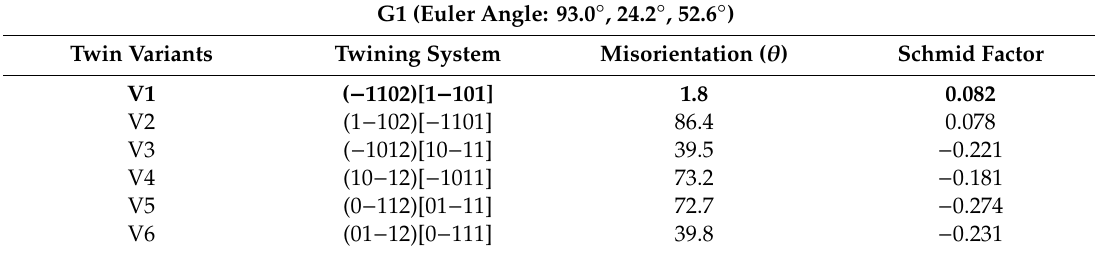
Table 3. Misorientation ( θ ) between the theoretical twin variants and observed twin variant in G1 (activated twin variant marked in bold).